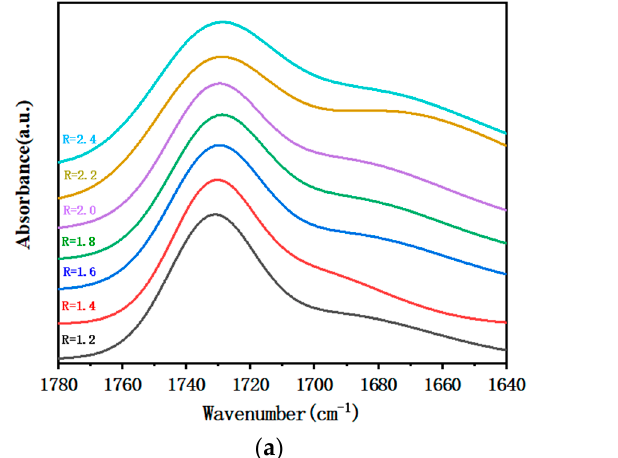
Figure 2. FT − IR spectrum of polymer fi lms with di ff erent R. Figure 2. FT-IR spectrum of polymer films with different R.